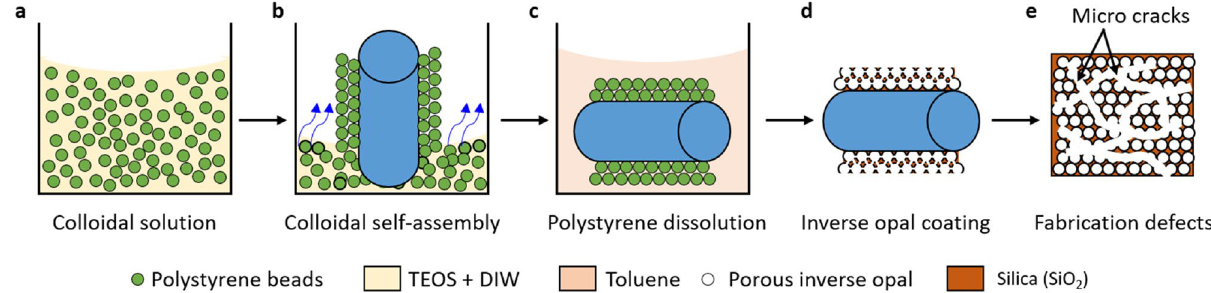
Figure 2. Schematic depiction of the fabrication procedure to produce inverse-opal-coated copper tubes. ( a ) Colloidal solution is prepared by adding 0.5 wt% colloidal polystyrene particles (395 nm diameter) into a solution of 99.4 wt% deionized water and 0.1 wt% tetraethyl orthosilicate (TEOS). ( b ) A copper tube coated with silica via atomic layer deposition (ALD) and oxygen plasma cleaned is inserted vertically in the colloidal solution to allow colloidal self-assembly as the solution evaporates. ( c ) The polystyrene beads are dissolved by immersing the copper tube in toluene. ( d ) A porous inverse opal structure composed of a network of voids is created when the sacrificial polystyrene beads dissolve in toluene. ( e ) During the drying stage, interconnected micro cracks featuring large hydraulic conductivity form between islands of inverse